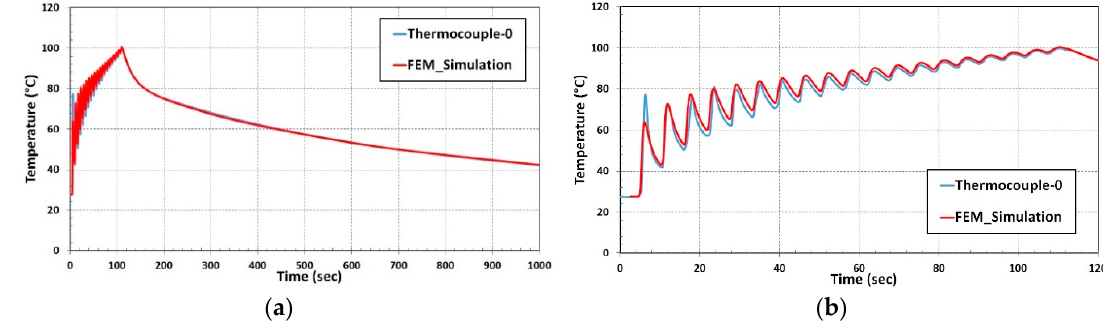
Figure 11. ( a ) Thermal validation for multi-track deposition; ( b ) Enlarged graph of Temperature vs. time during 19 track deposition.